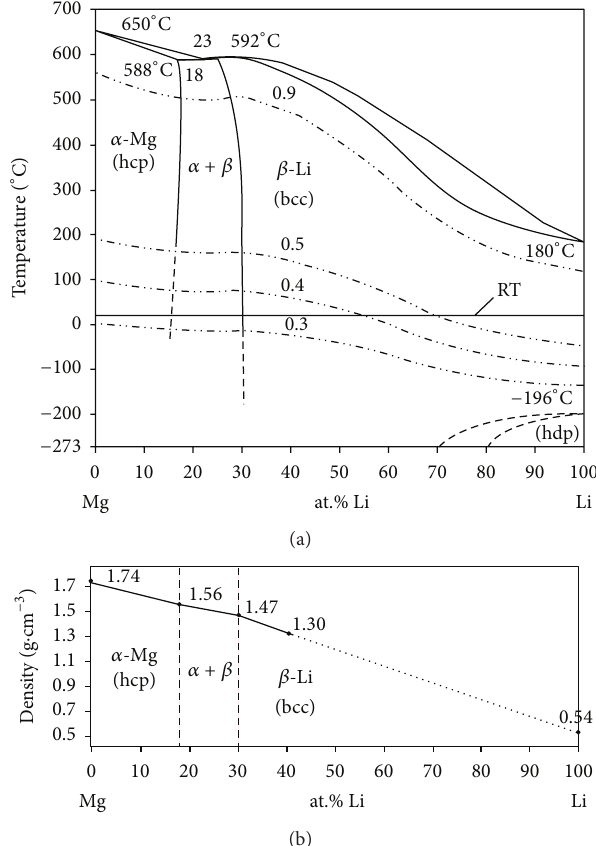
Figure 1: (a) Mg-Li binary phase diagram [3, 6]. (b) Lithium addition effect on alloy density